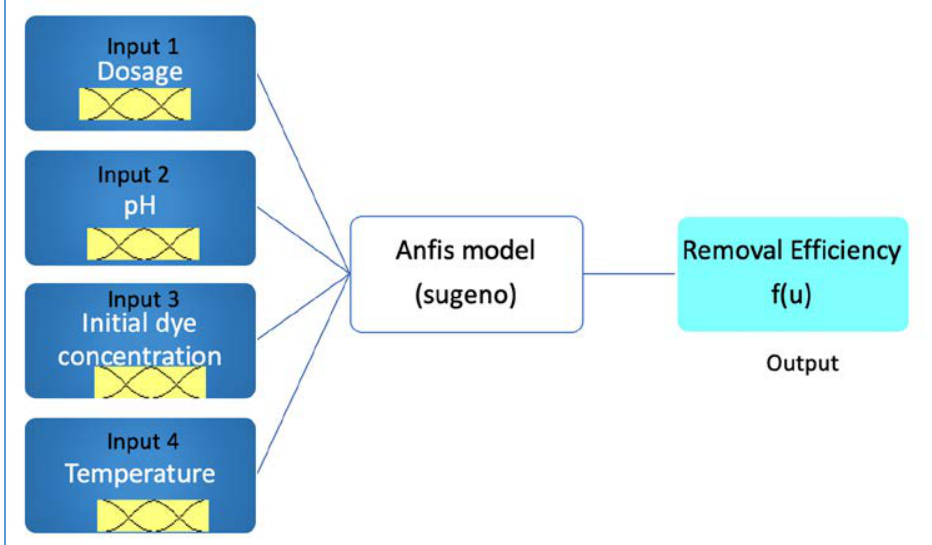
Fig. 1: ANFIS model for batch study